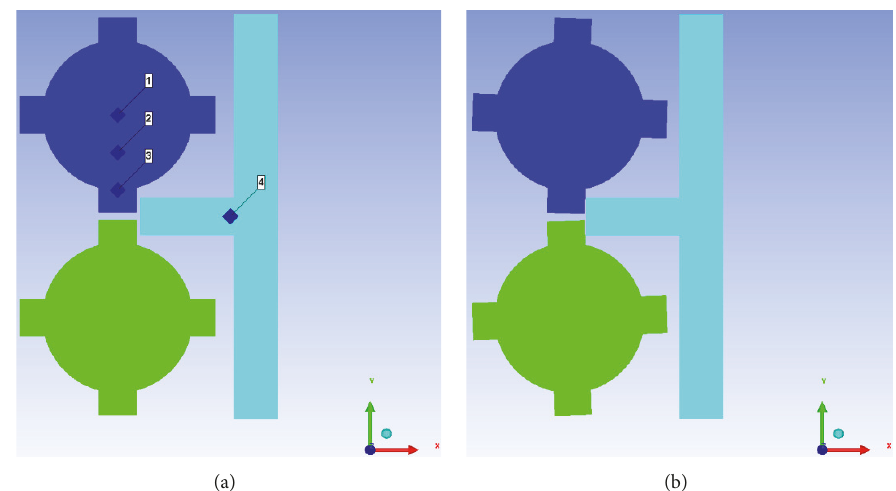
Figure 5: Illustration of the cladding: (a) before and (b) after the plate-flywheel